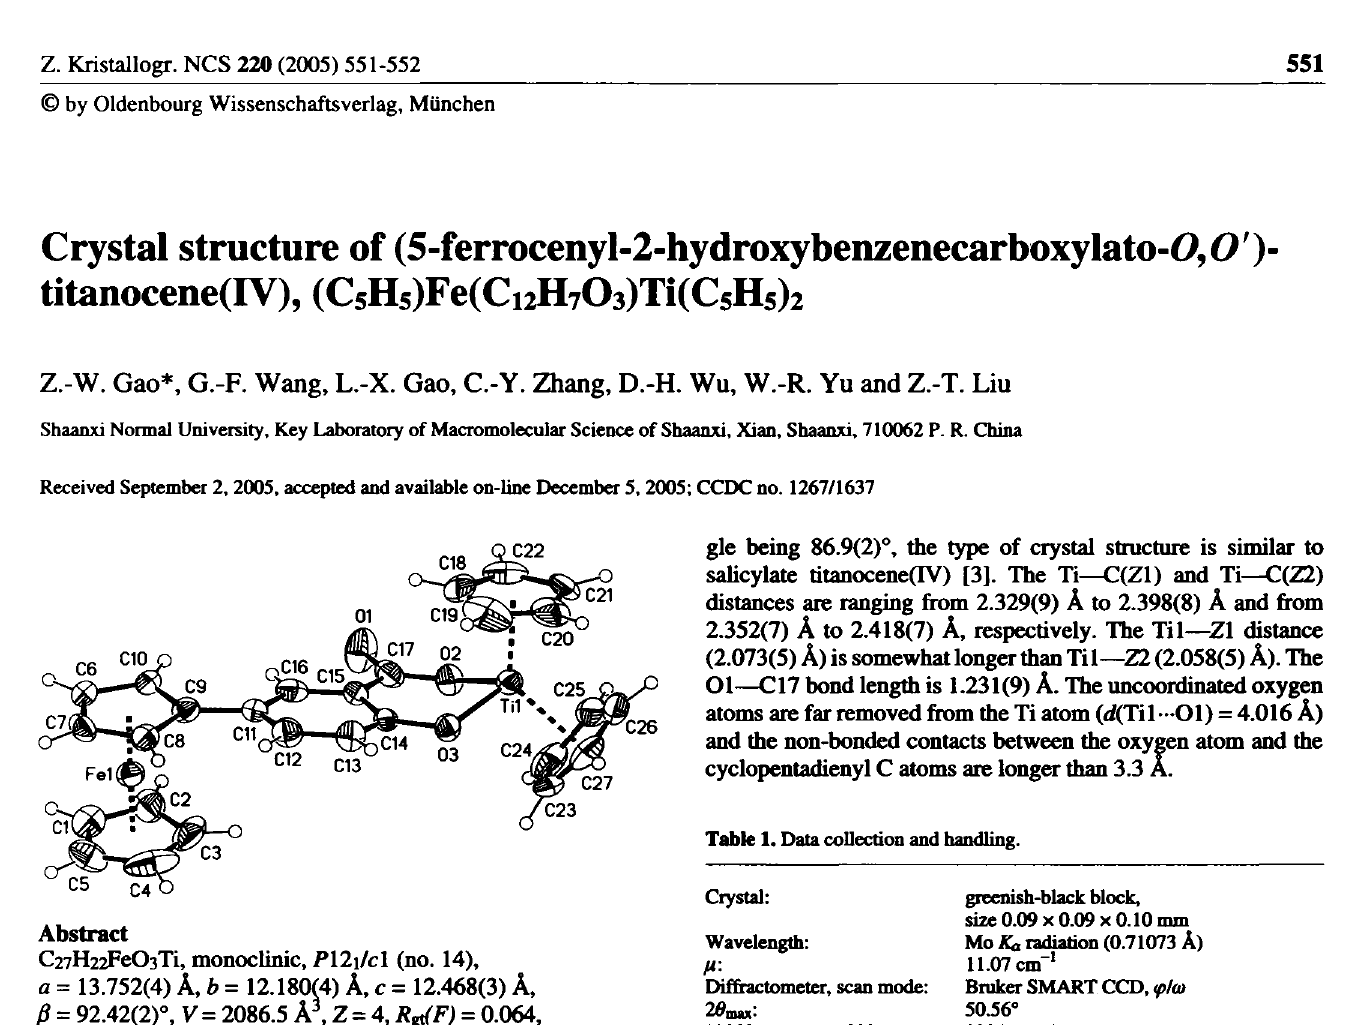
Table 1. Data collection and handling